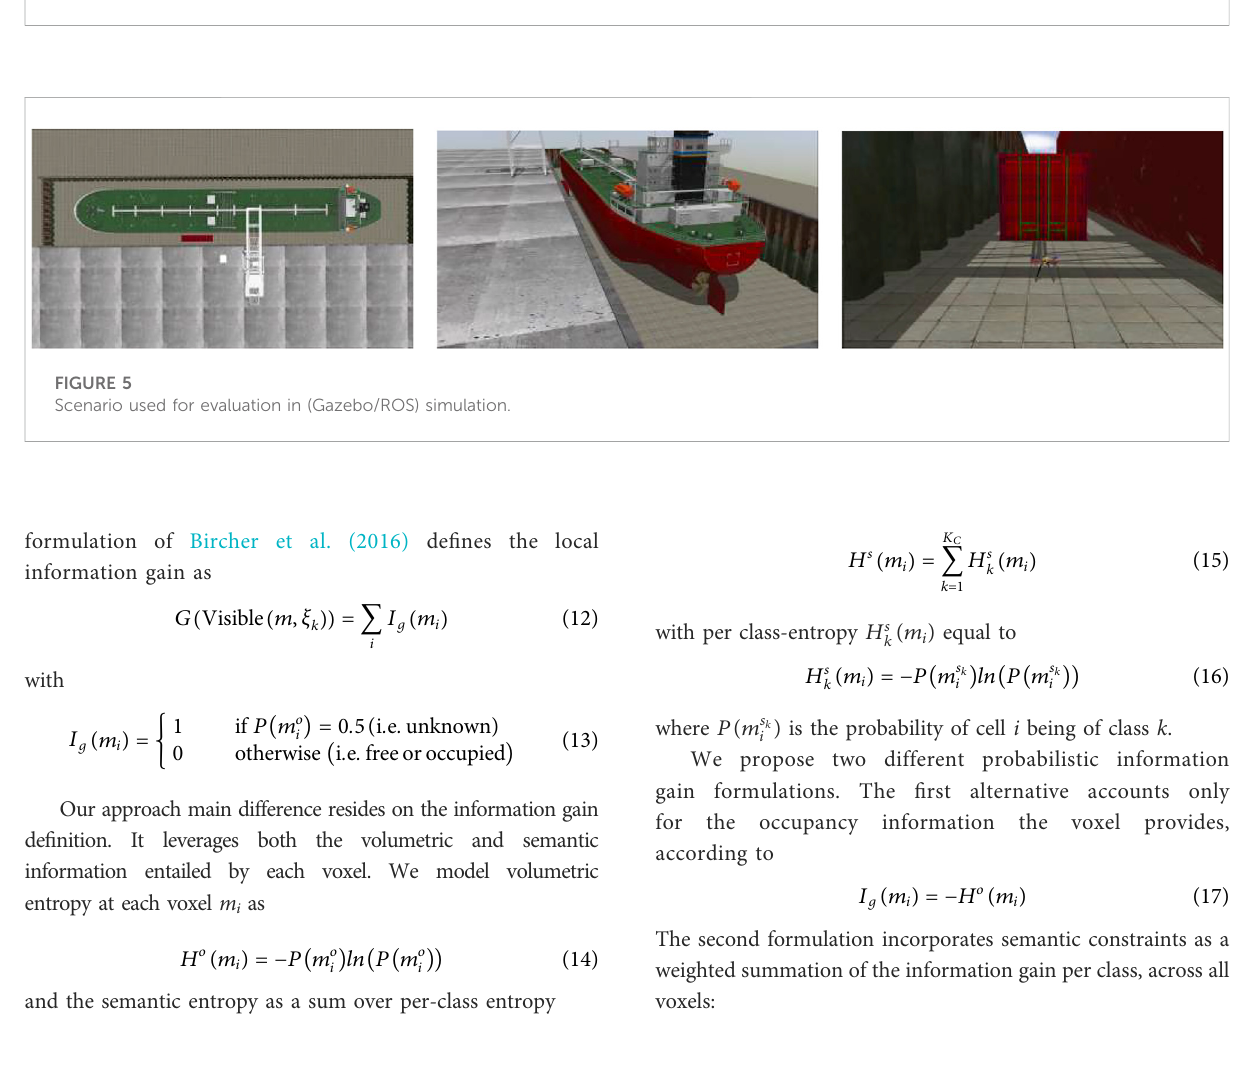
FIGURE 4 Pixel-level confusion matrix of our semantic network in gazebo and real-world images. (A) Gazebo (93% IoU score), (B) Real-world (76.6% IoU score).